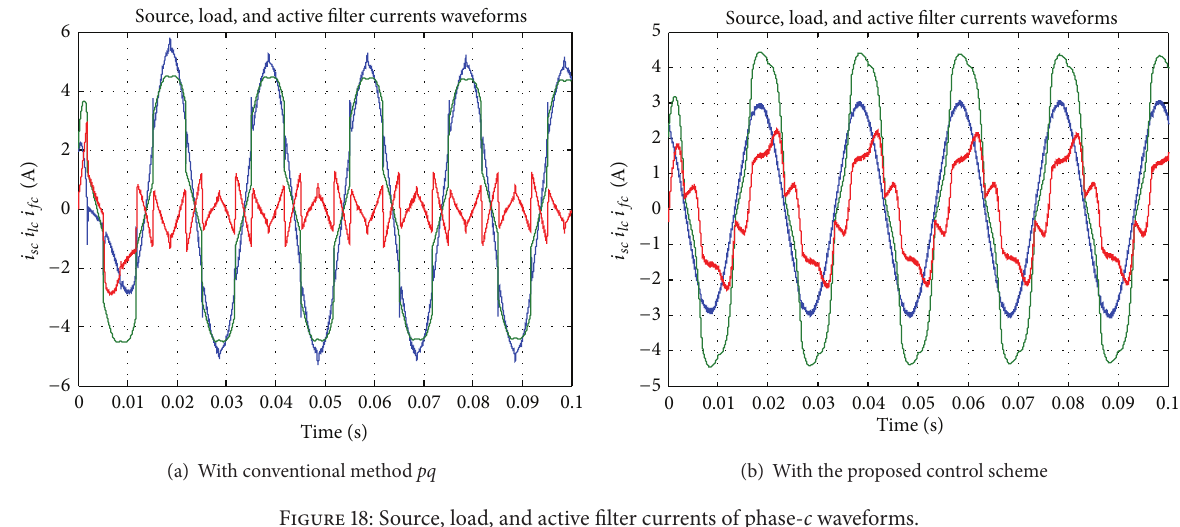
Figure 18: Source, load, and active filter currents of phase- c waveforms.